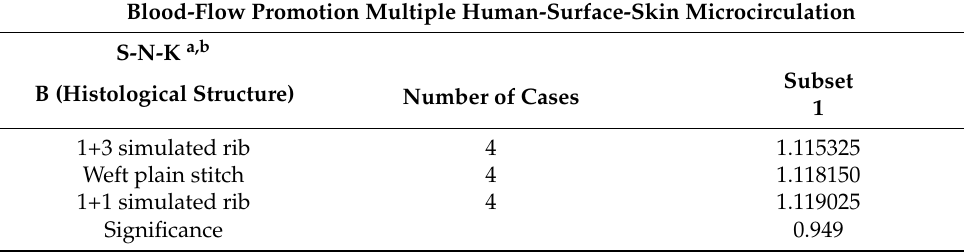
Table 7. Comparison of tissue structure in promoting multiple blood flow on skin